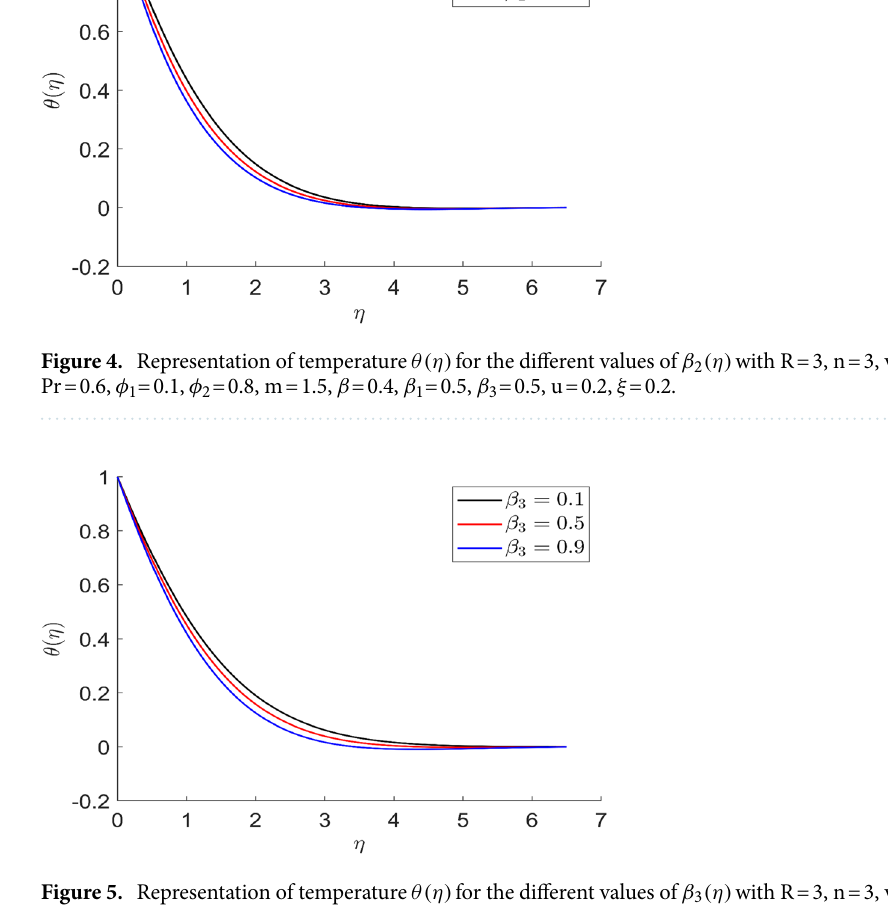
Figure 5. Representation of temperature θ(η) for the different values of β 3 (η) with R = 3, n = 3, v = 0.7, φ = 0.3, Pr = 0.6, φ 1 = 0.1, φ 2 = 0.8, m = 1.5, β = 0.4, β 1 = 0.5, β 2 = 0.9, u = 0.2, ξ = 0.2.